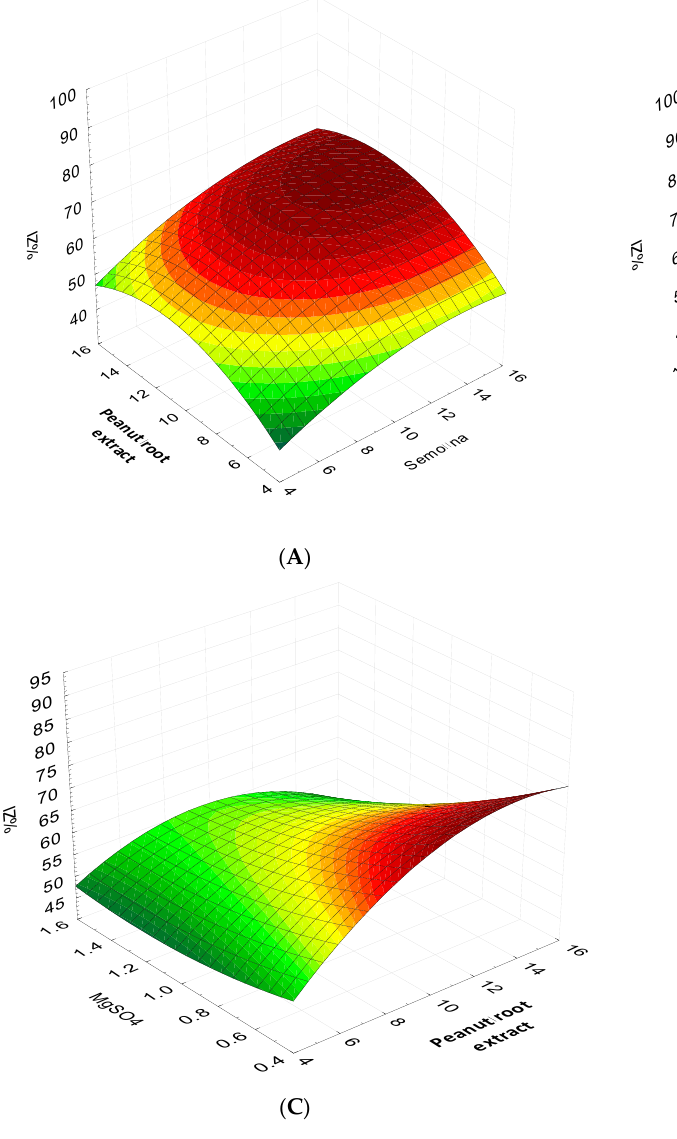
Figure 2. Response surface plots of the e ff ect of various factors on the inhibition rate of P. arachidicola growth by the fermented broth of the B. velezensis BP-1 strain and validation of the optimal formu- lation. ( A ) The response surface plot for the e ff ects of semolina fl our and peanut root extract on the inhibition rate at middle-level MgSO 4 content. ( B ) The response surface plot for the e ff ects of semo- lina fl our and MgSO 4 on the inhibition rate at middle-level peanut root extract content. ( C ) The re- sponse surface plot for the e ff ects of peanut root extract and MgSO 4 on the inhibition rate at middle- level semolina fl our content. During the fermentation process, the total sugar, amino nitrogen content, pH, and dry mycelium weight were measured. In order to characterize the relationships between the independent variables, linear and exponential models were used. The total sugar con- centration was high at the beginning of the fermentation process, but it gradually dropped due to increased usage. A linear regression model (R 2 = 0.9609) depicts the relationship between total sugar and time. The exponential decay model yielded the best- fi t regression,